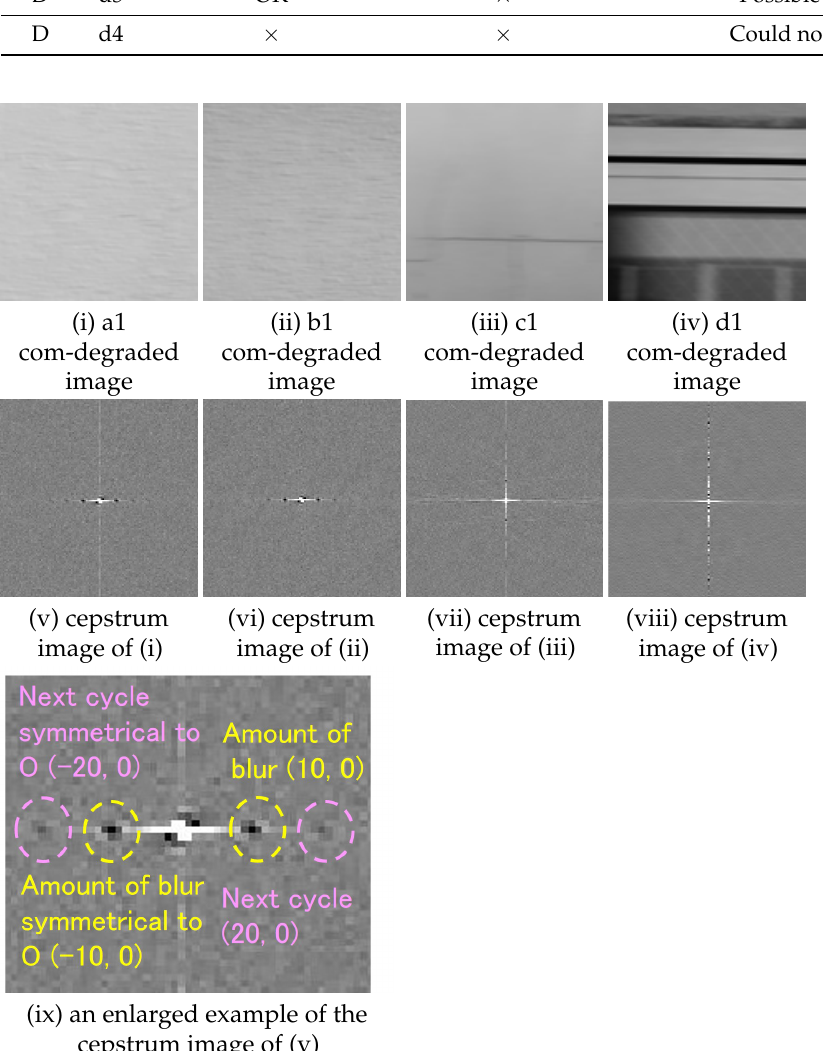
Figure 5. Examples of com-degraded image(10 pixels, 0 degrees) and cepstrum image from area A to D (121 × 121